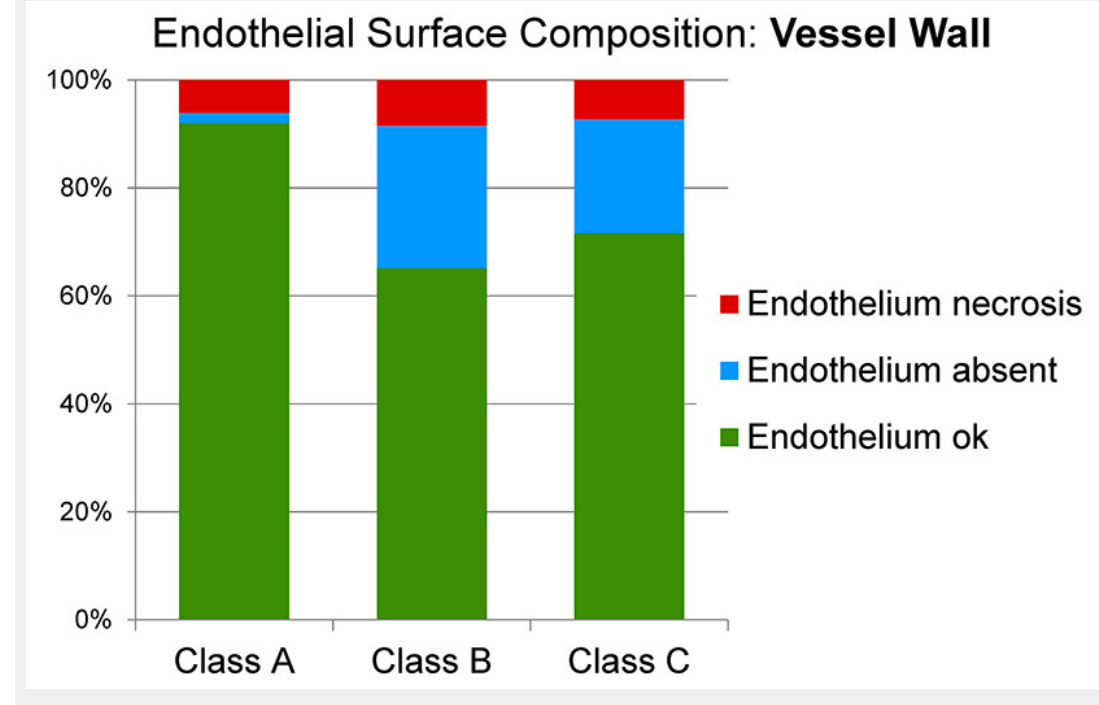
Figure 7 Surface analysis of the endothelium of the vessel wall in the three classes of venous disease (A: minimal; B: early stage; C: